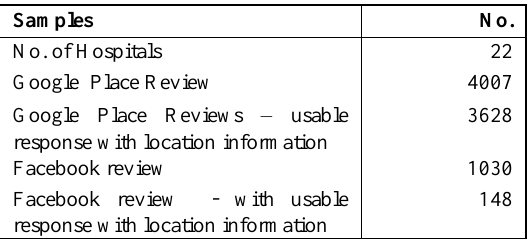
Table 1: Sample Profile